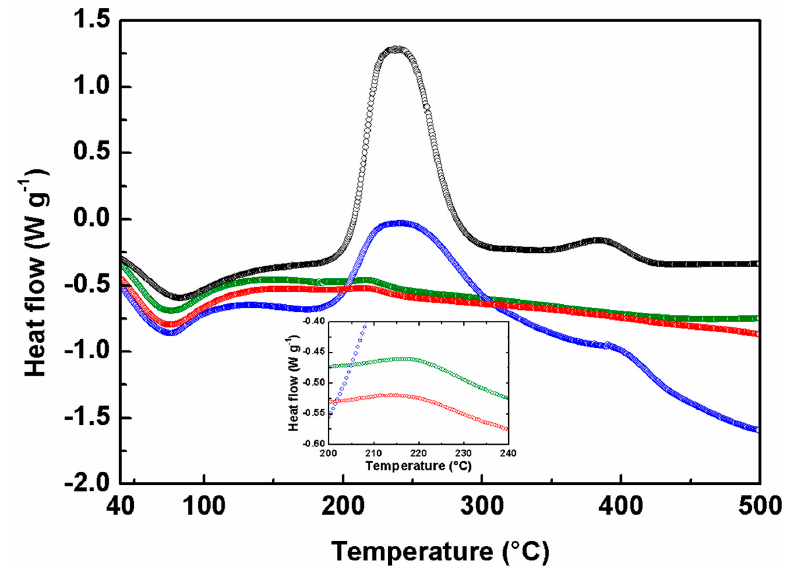
Figure 2. DSC analyses of sample A (green), sample B (red), sample C (blue) and sample D (black). In the inset the peaks at 215 °C for samples A and B are enlarged (Color figure online). Table 1. Surface areas determined for the different samples.